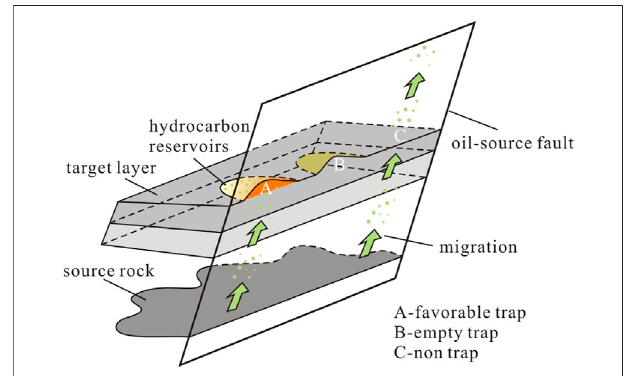
FIGURE 1 | Schematic diagram of hydrocarbon accumulation patterns controlled by an oil-source